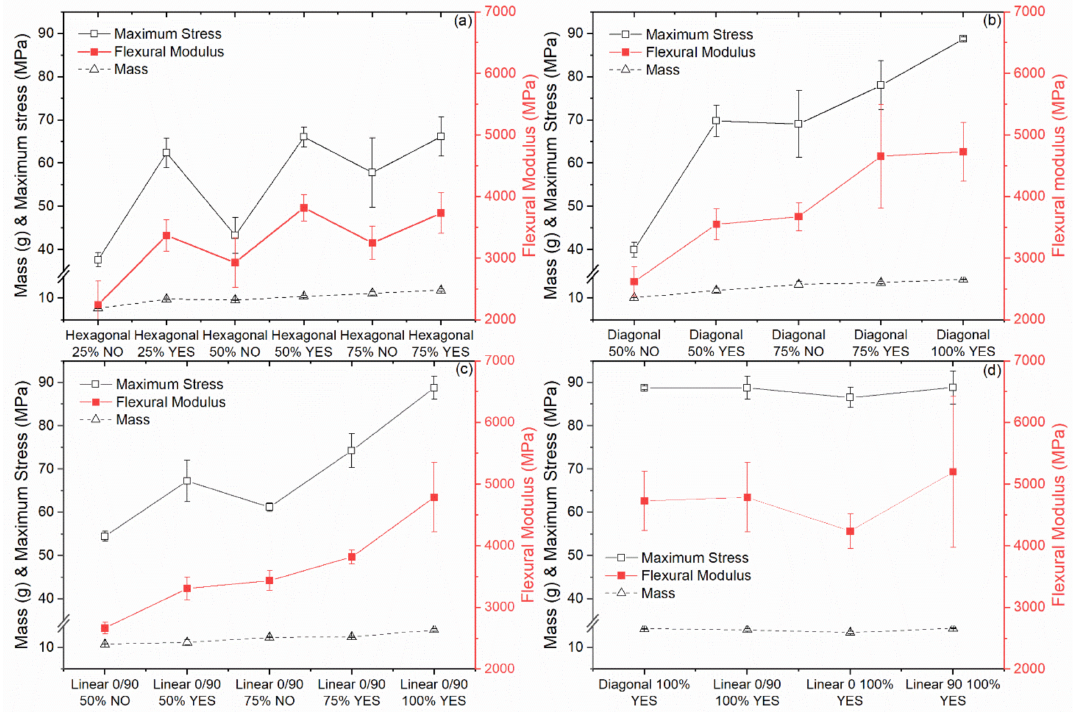
Figure 9. Average maximum flexural stress, flexural modulus and mass for sintered specimens with different infill patterns: ( a ) Hexagonal, ( b ) diagonal 45/45, ( c ) linear 0/90 and ( d ) 100% filled with 4 different